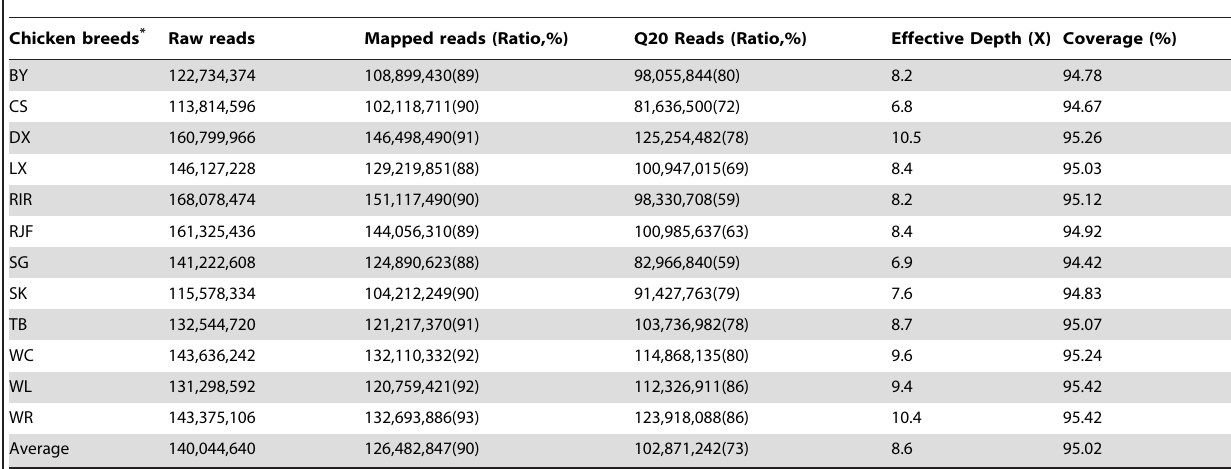
Table 1. Summary of sequencing and mapping